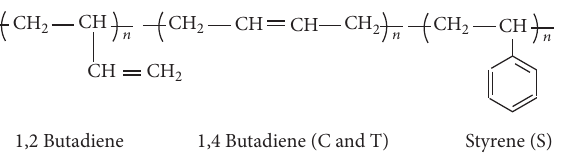
Figure 3: The structure of the styrene-butadiene block copolymer [12].